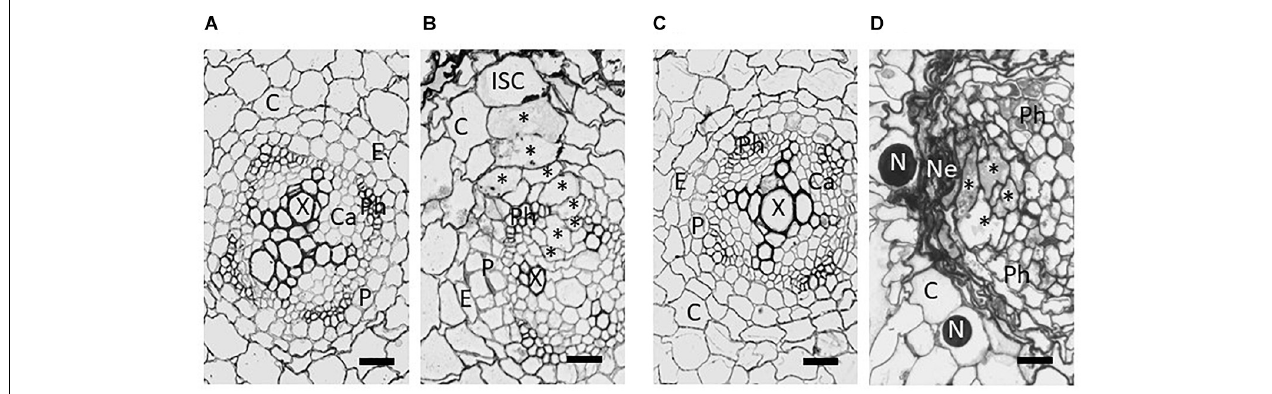
FIGURE 2 | Brightfield images from tangential sections of potato roots showing development of syncytia induced by Globodera pallida in the roots of susceptible Solanum tuberosum cv. Pentland Ivory (A,B) and resistant reaction of Sa_12601 [ S. tuberosum ssp. andigena CPC 2802 ( H3 )] (C,D) . (A) Uninfected root and (B) syncytium at 4 dpi of susceptible cv Pentland Ivory, (C) uninfected and (D) necrosis and collapse of syncytium at 7 dpi of Sa_12601. C, cortex; Ca, pro-/cambium; E, endodermis; ISC, initial syncytial cell; N, nematode; Ne, necrosis; P, pericycle; Ph, phloem; X, xylem. Asterisks (*) indicate selected syncytial elements. Scale bars: 20 µ m (from Varypatakis et al.,